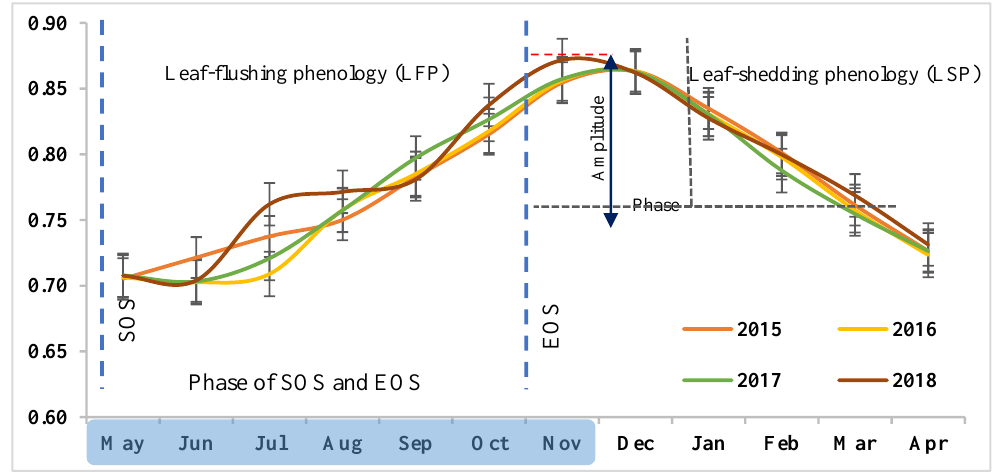
Figure 6. Fitted phenological profile of Landsat 8 OLI EVI composite data for bamboo forest. Remote Sens. 2020 , 12 , x FOR PEER REVIEW